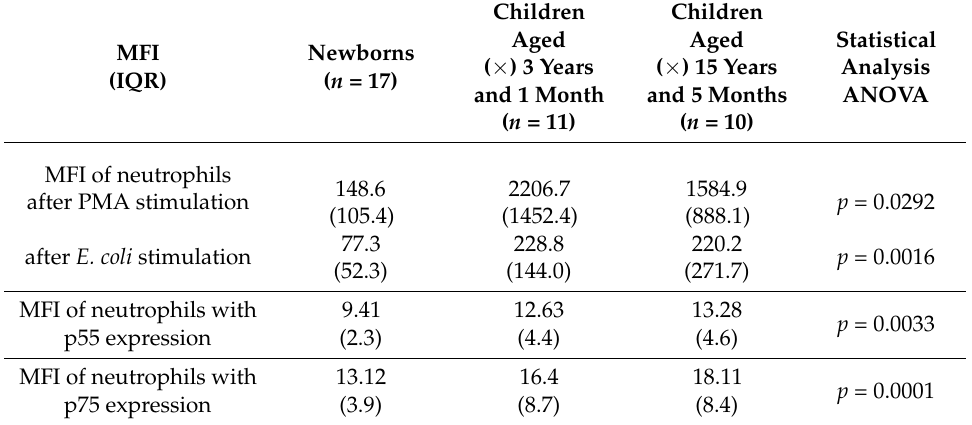
Table 5. The fluorescence intensity of neutrophils in the control